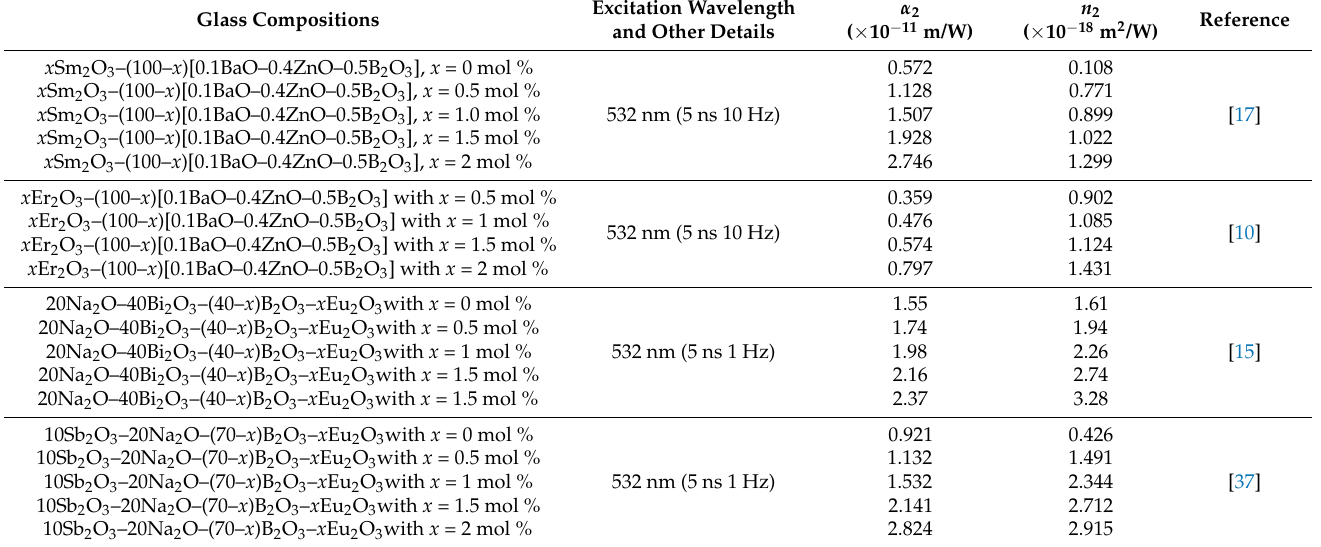
Table 1. NLO coefficient of some RE incorporated glasses reported recently for the comparison purpose. Glass Compositions